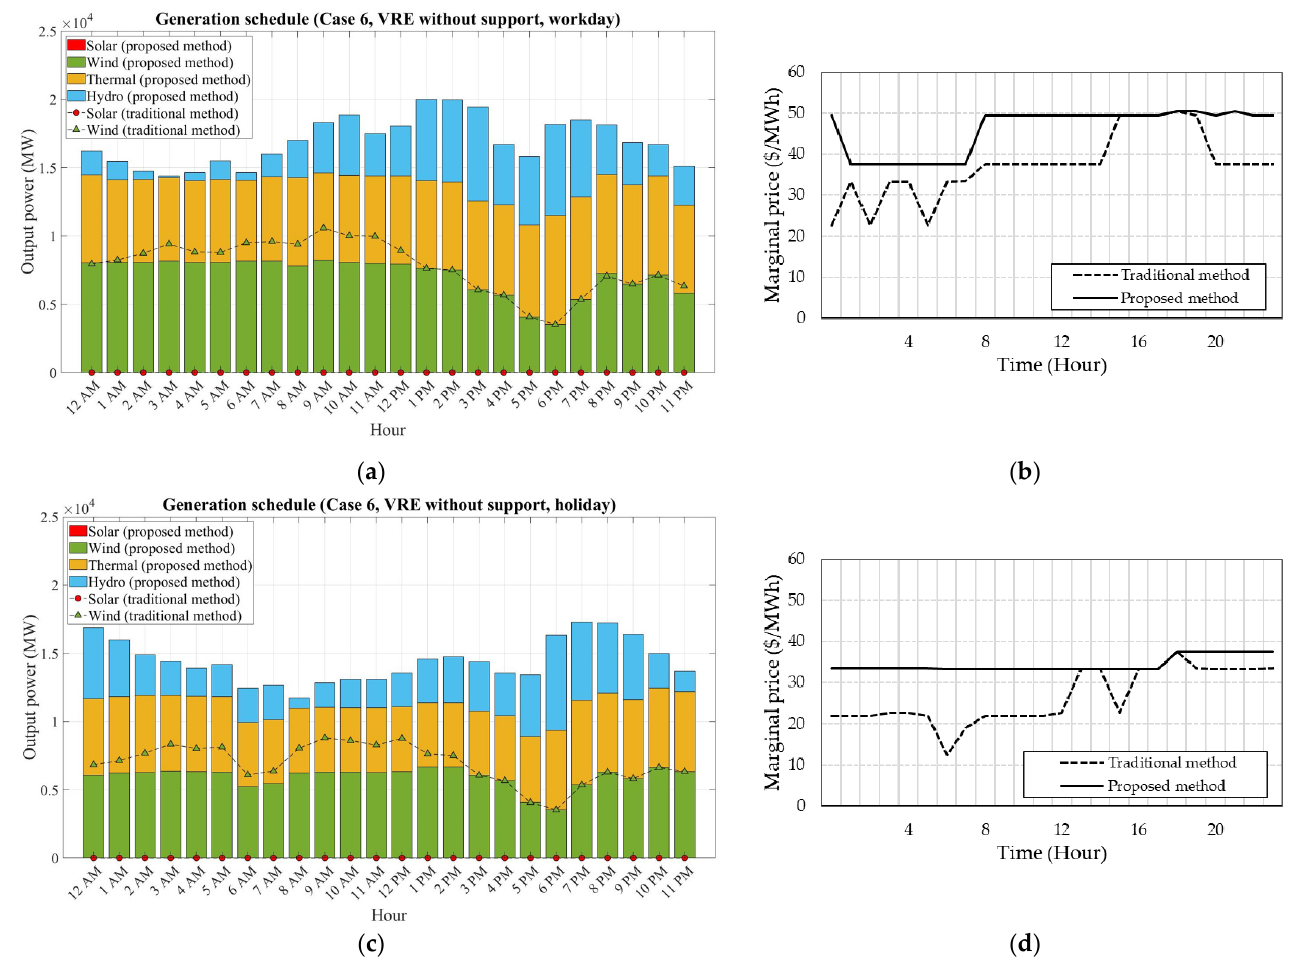
Figure 6. ( a ) The optimal VRE generation schedule on the workday of case 6, where VRE received no support. ( b ) The MP on the workday of case 6 in the in the scenario of VRE receiving no support. ( c ) The optimal VRE generation schedule on the holiday of case 6 in the in the scenario of VRE receiving no support schemes. ( d ) The MP on the holiday of case 6 in the scenario of VRE receiving no support schemes.